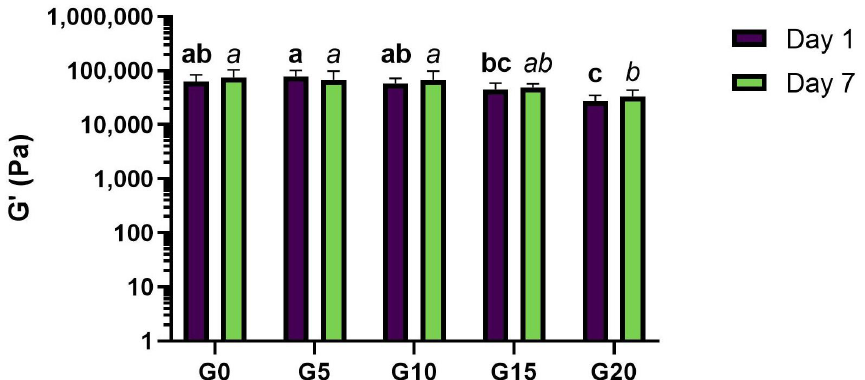
Figure 7. Elastic moduli of fermented PPI gels at 1 Hz after 7 days of storage under refrigeration at 5 °C. Sample name corresponds to its oil content, e.g., G0: 0% oil, G5: 5% oil, etc. Significant differences between samples were highlighted by different letters within day 1 (bold) and day 7 (italics),